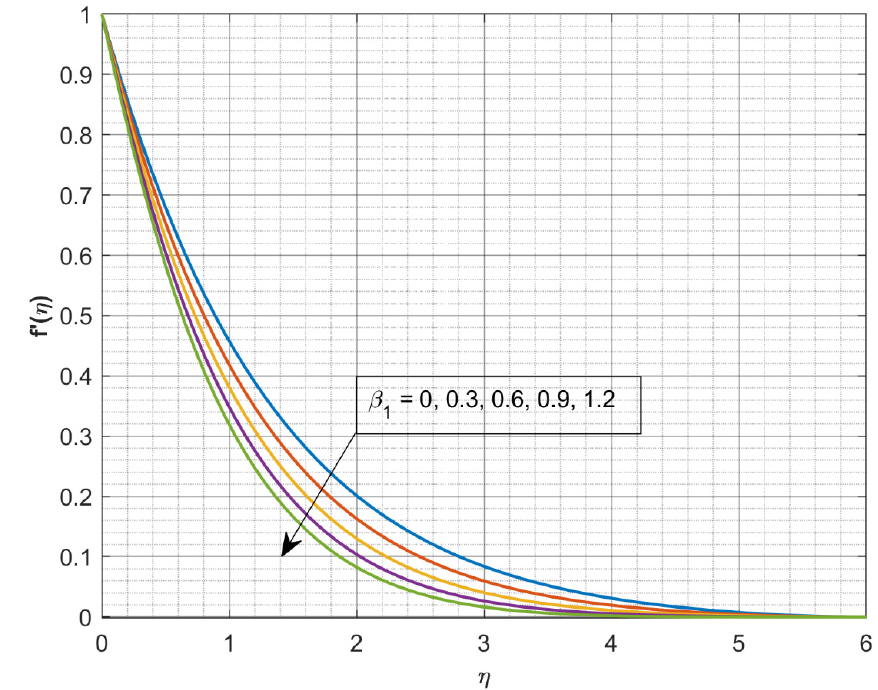
Figure 3. Influence of β 1 on f (cid:48) ( η ) .